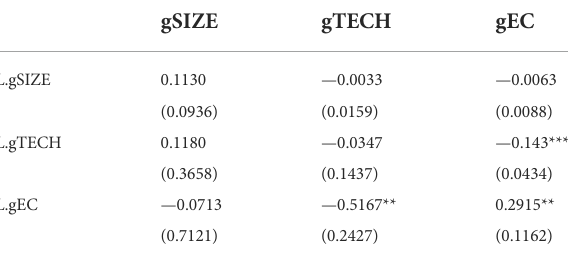
TABLE 2 Panel unit root test results.